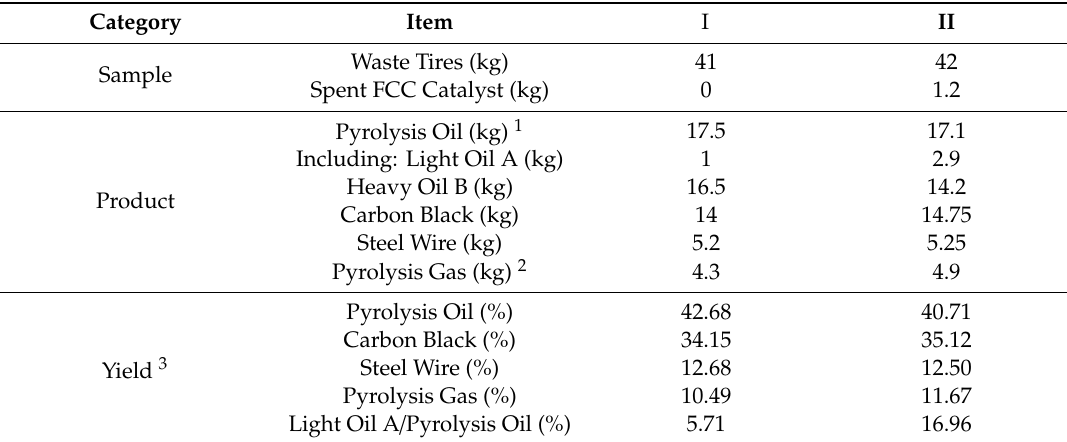
Table 3. Proximate analysis of feedstock.